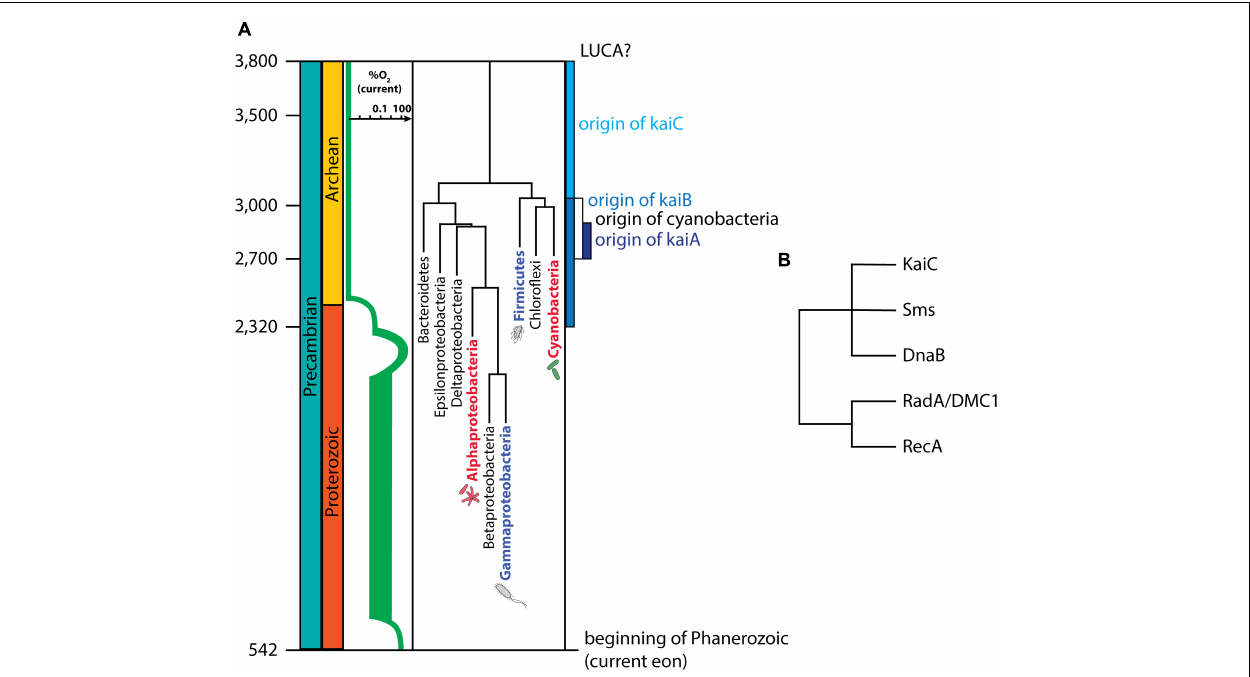
FIGURE 3 | Evolution of the cyanobacterial circadian clock genes. (A) Timeline of the evolution of the three core cyanobacterial clock genes, kaiA , kaiB, and kaiC , compared with the timing of the Great Oxidation Event [in green, oxygen levels in relationship to today’s atmosphere (based on Lyons et al., 2014)], and the evolution of Eubacteria (timing based on estimates by TimeTree (Hedges et al., 2015; Marin et al., 2016) added for evolutionary context. The date of the origin of kaiA is directly extracted from recent studies (Dvornyk and Mei, 2021), while dates for kaiB and kaiC are based on previous work (Dvornyk et al., 2003) after adjusting for the most current estimates of the origin of Cyanobacteria. All taxons represented in the figure contain copies of kaiC , although not all groups with kaiC are shown, and non- kaiC -containing groups are not included for simplicity. Labels shown in red are bacterial groups that have a KaiBC-based timer [a KaiABC-based circadian clock in the case of Cyanobacteria, and a KaiBC “proto-clock” (hourglass timer?) in the case of Rhodopseudomonas (Ma et al., 2013)]. Blue-font labels indicate other Eubacteria in which a potential circadian clock has been described: Bacillus subtillis (Firmicutes) and Klebsiella aerogenes (Gammaproteobacteria). The origin of cyanobacteria is based on estimates by Blank and Sanchez-Baracaldo (2010), which is in general agreement with other reports. LUCA refers to the Last Unique Common Ancestor. (B) Protein tree of KaiC and other proteins in the RecA/DnaB superfamily (based on Leipe et al., 2000; Makarova and Koonin,